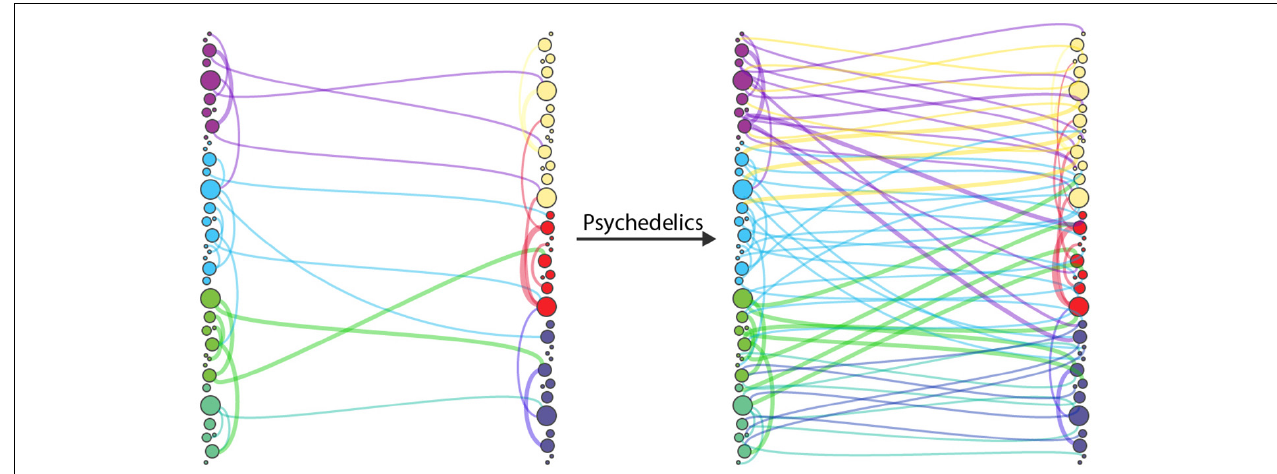
FIGURE 1 | Illustration of desegregated connectivity under psilocybin, inspired by Petri et al. (2014). Change between cortical communities’ diversity of connectivity under psilocybin suggests a foundation of subjective effects (and facet of ego dissolution) that may be underwritten by reduced precision (i.e., confidence) of belief updating enabling connectivity to select from a wider range of